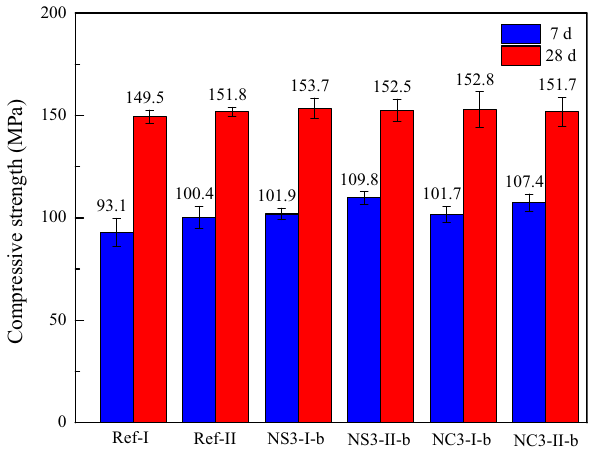
Figure 10: E ff ect of steel fi bre type on the resulting UHPC com - pressive strength.